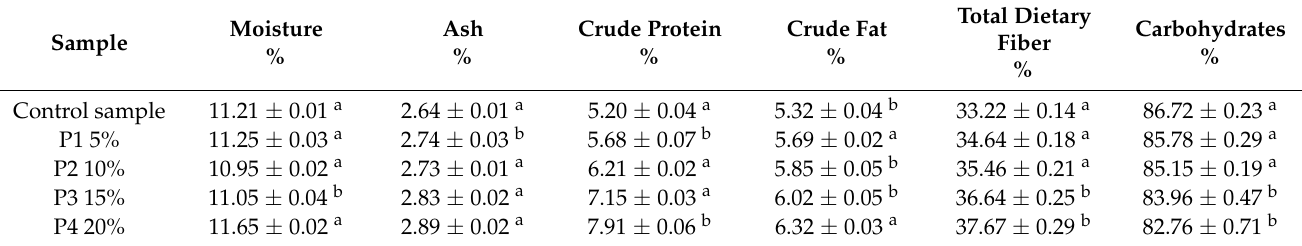
Table 8. Proximate analysis of pasta